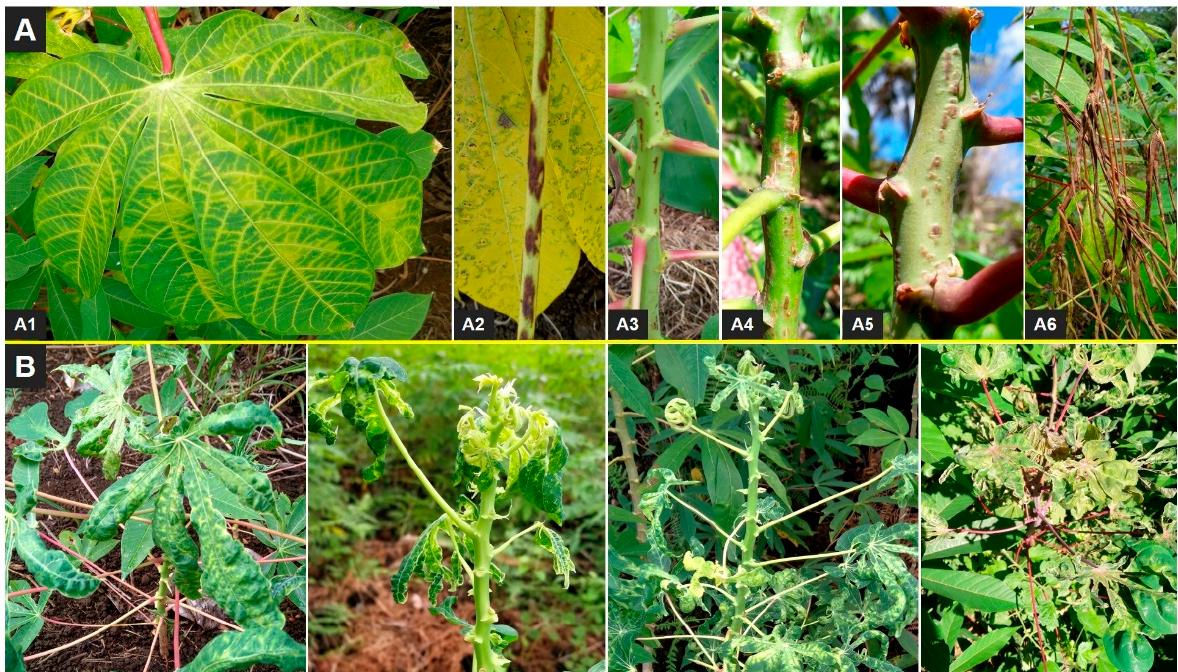
Figure 2. Foliar symptoms of cassava brown streak disease (CBSD) and cassava mosaic disease (CMD) observed in Comoros, July, 2019. Panel ( A ): Different foliar symptoms of CBSD observed on different varieties in Comoros: ( A1 ), feathery necrotic lesions on leaf; ( A2 ), necrotic lesions on leaf petiole; ( A3 – A5 ), different patterns of necrotic lesions observed on the green parts of shoots of dif- ferent varieties; ( A6 ), shoot of cassava showing severe necrotic lesions and dieback. Panel ( B ): CMD symptom patterns observed on different cassava varieties in Table 2. Comparison of cassava brown streak disease, cassava mosaic disease symptoms, and Be- misia tabaci abundance across three islands in Comoros, July 2019. Bemisia CMD CBSD CMD Island Sites tabaci Sev. Sev. Wf